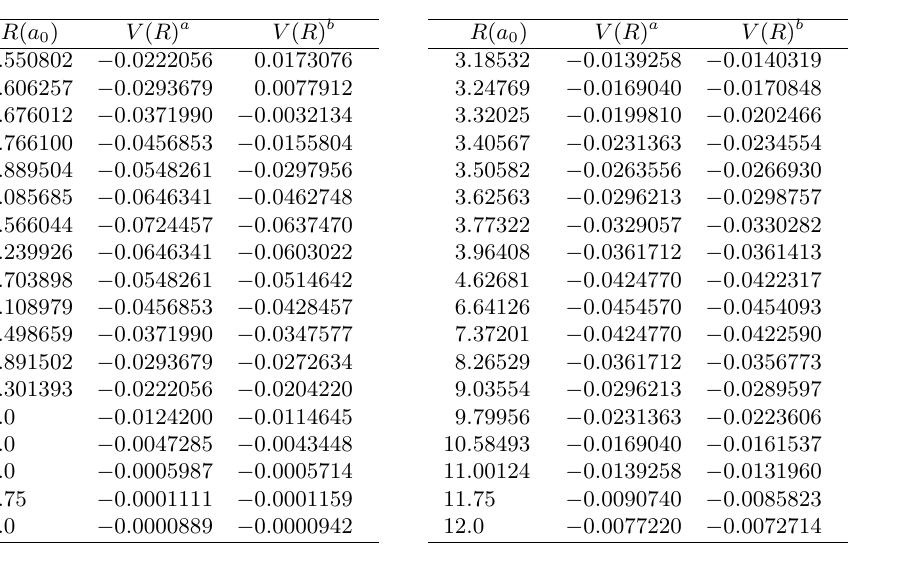
Table 3. Interaction potential en- Table 4. Transition Li 2p 2 P{2s 2 S at 670.97 nm broadened by helium. Half half-widths w=N